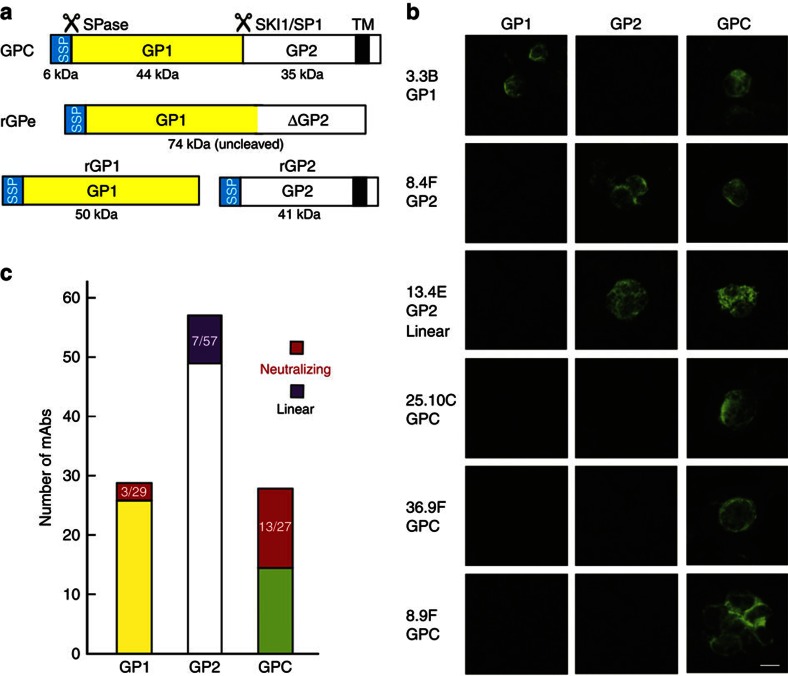
Subunit specificity of LASV mAbs.(a) The LASV GPC is synthesized as a precursor protein. Signal peptidase (SPase) cleaves the small SSP, which remains associated with the complex. SKI protease (SK1/S1P) cleaves GPC into GP1 and GP1. A recombinant LASV (Josiah strain, lineage IV) GPC ectodomain construct (rGPe) was expressed that substituted an uncleavable linker for the SK1 site and deleted the transmembrane and extracellular domains. Constructs expressing recombinant SSP-GP1 (rGP1) and SSP linked to GP2 were also utilized. Molecular weights are indicated in kiloDaltons (kDa). (b) Examples of immunofluorescence assays with unfixed, air-dried cells expressing GP1, GP2 or GPC. All assays were performed two or more times. Scale bar, 10 μm. (c) Distribution of 113 mAbs by subunit specificity, neutralizing activity and reactivity to linear peptides.